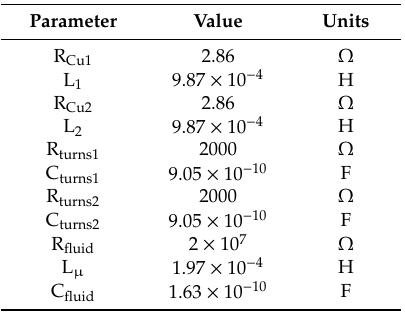
Table 1. Simulation model, initial